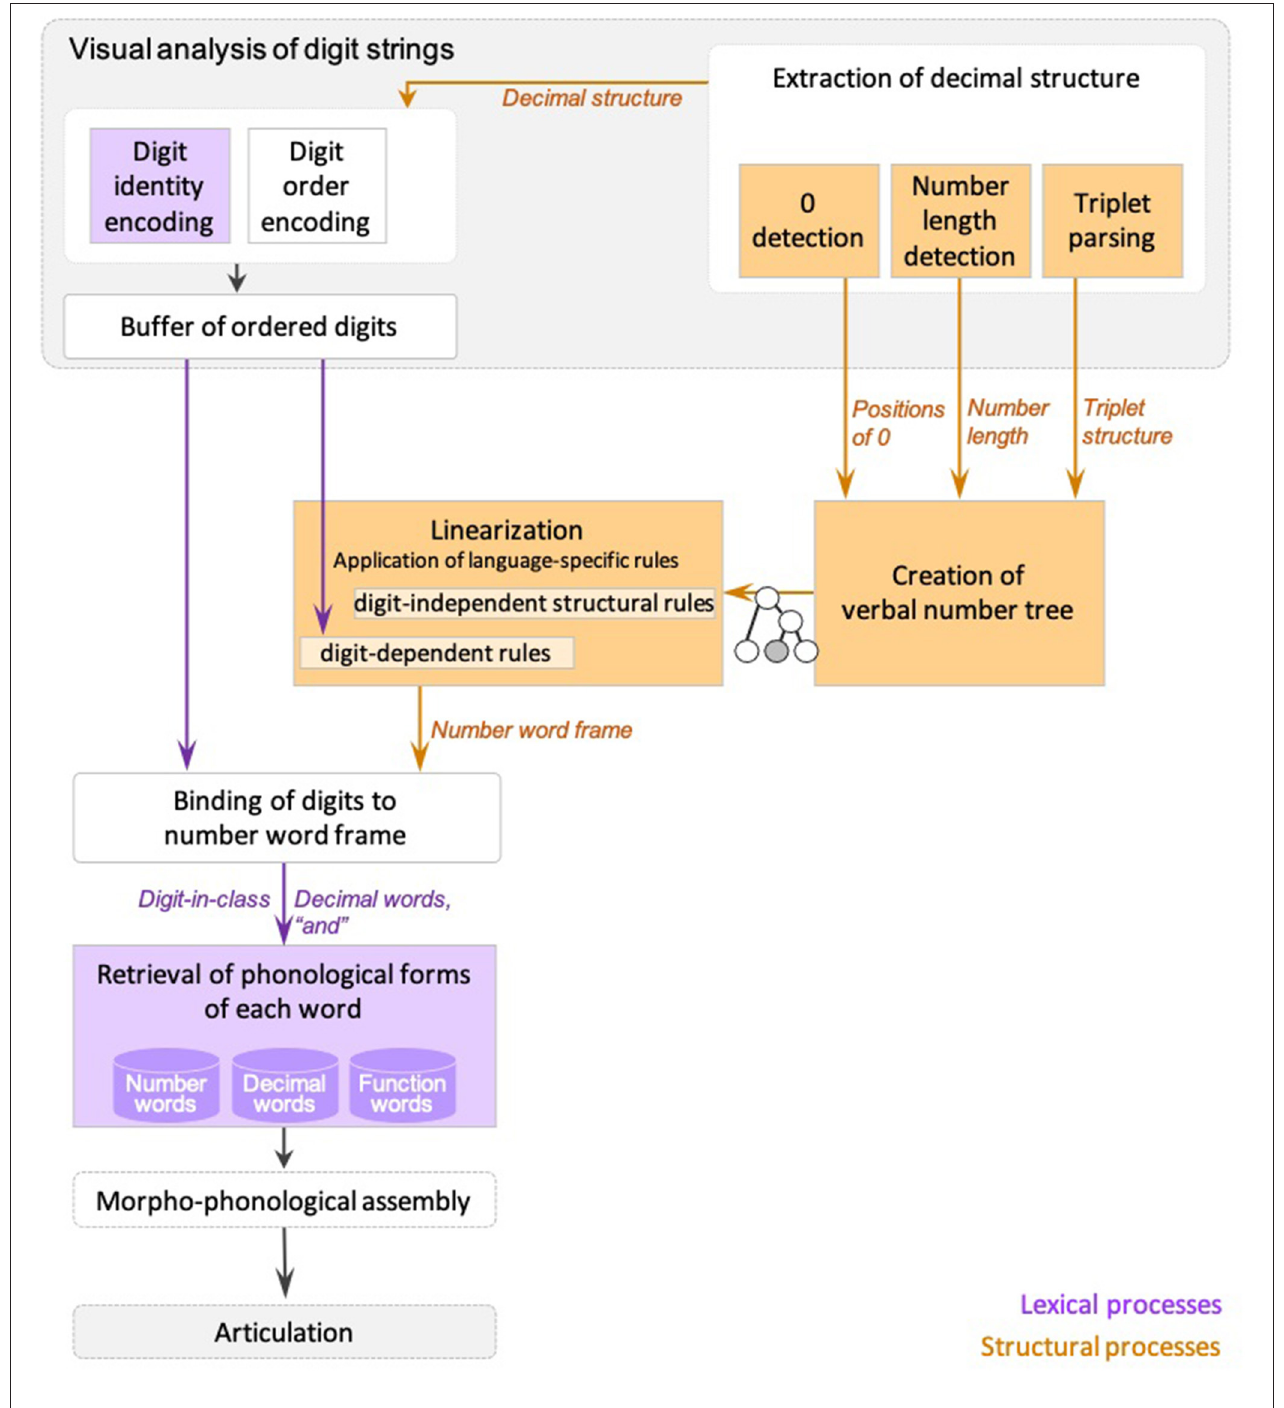
FIGURE 1 | The number reading model from Dotan and Friedmann